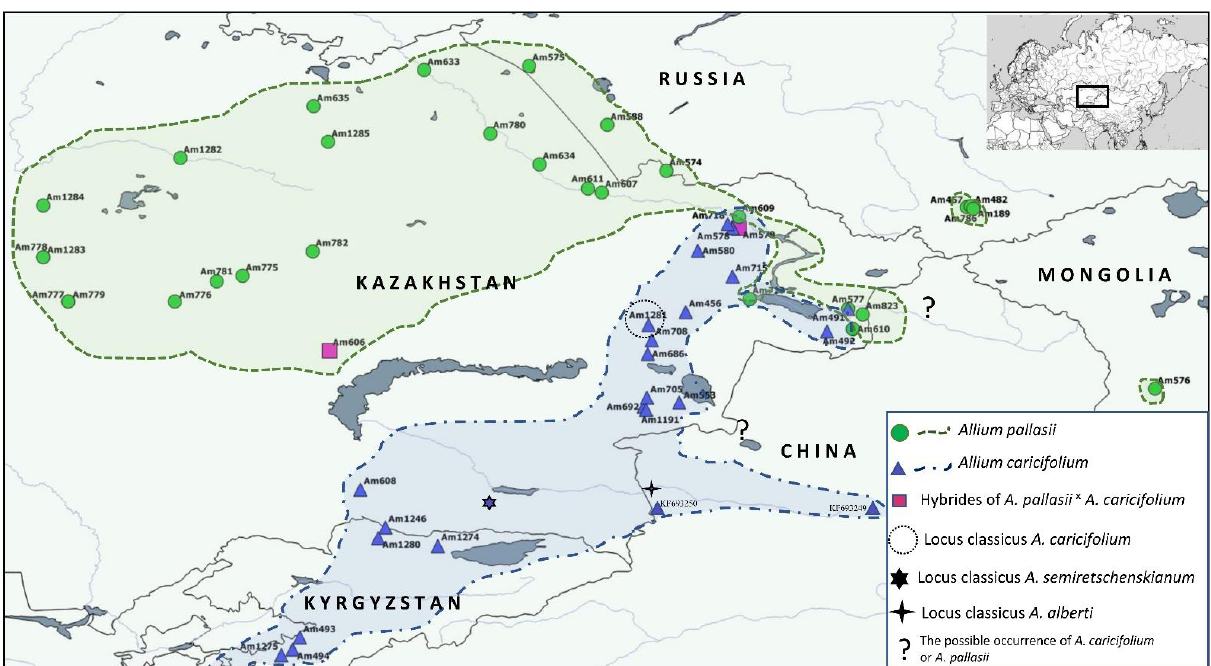
Figure 1. The geographic location of collected accessions and distribution of A. pallasii and A. caricifolium . Table 1. Comparison of morphological characters of A. pallasii (20 individuals) and A. caricifolium (22 individuals). Quantitative characters are expressed in mm and presented as mean ± standard deviation (extreme values in brackets).